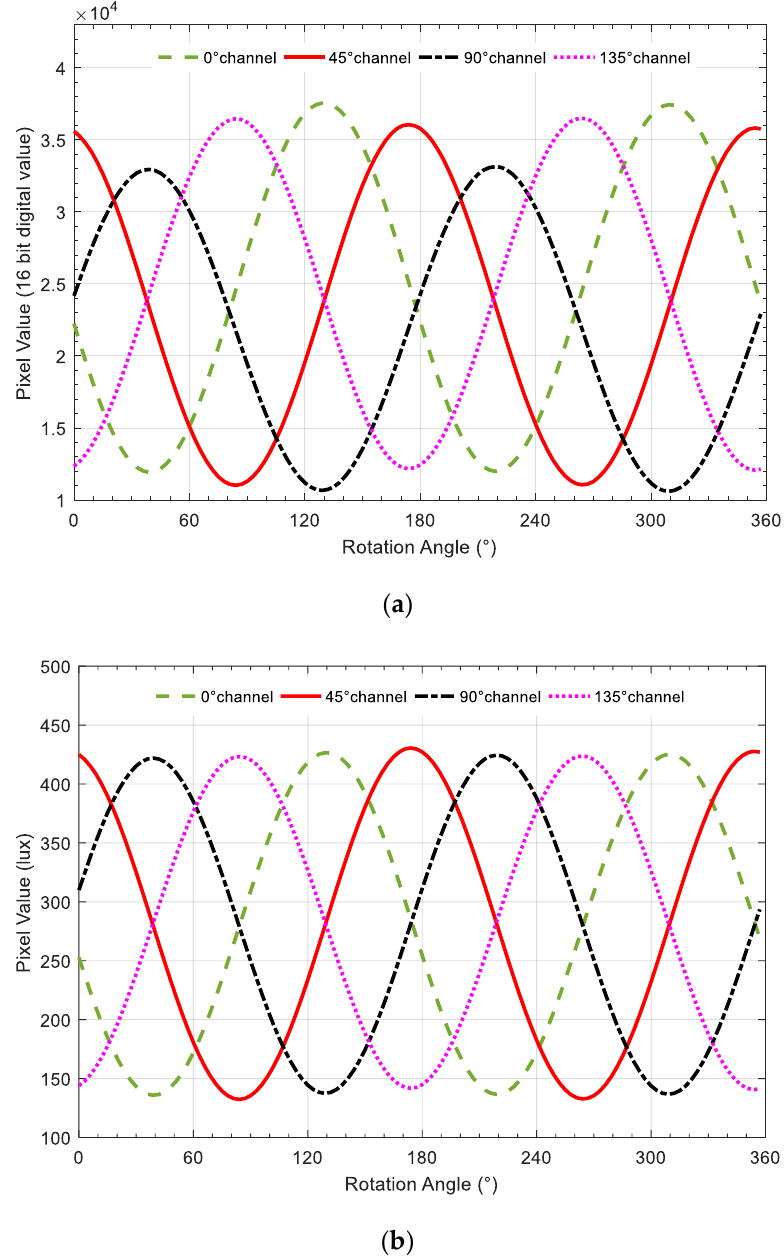
Figure 5. Indoor calibration experiment diagram. ( a ) four-channel light-intensity response curve before calibration; ( b ) four-channel light-intensity response curve before calibration. The calibrated coe ffi cients of the CMOS camera photosensitivity model were used to correct the original light-intensity data and the standard deviations (SD) of AOP and DOP of every image rotating with the rotary platform before and after calibration were compared, as shown in Figure 7. The standard deviations of AOP and DOP of every polarization unit are decreased by 8% and 7%, respectively; As can be seen from Figure 7a, the sinusoidal fluctuation of standard deviation of AOP in each image is greatly reduced after calibration. The standard deviation of AOP calculated within the rotation angle range of 110 to 130 before calibration is smaller than after calibration, which can be attributed to the positive and negative o ff sets when calculating AOP based on Equation